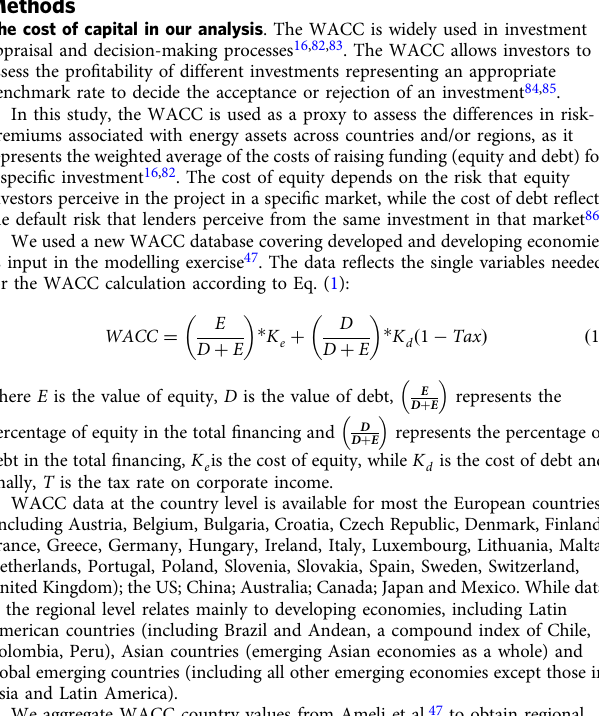
(Table 1). We used GDP weighting for regions where we had data for different countries within the same regions (for example WEU or CSA). The same mechanism has been used to calculate the global value used in the GBL scenario. We decided to use GDP weighting as it correlates well with levels of energy investment 87